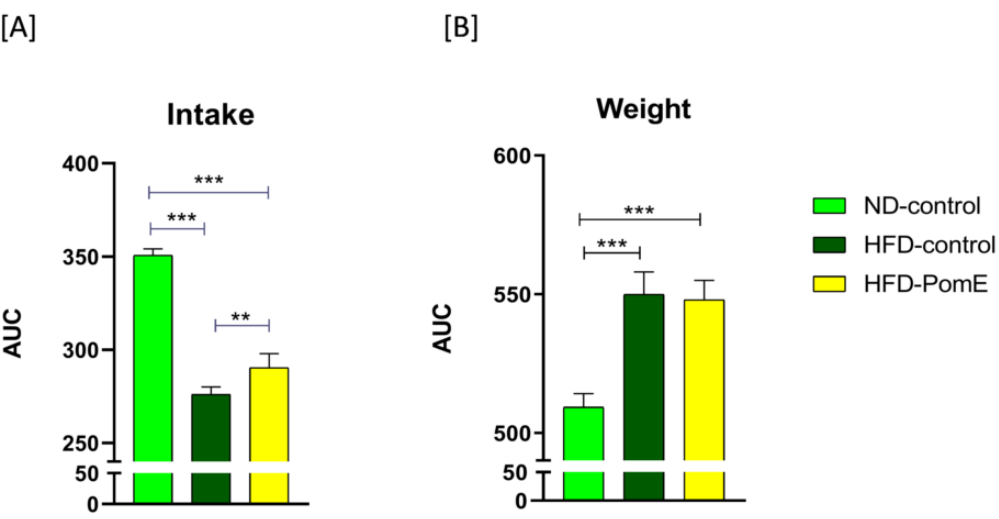
Figure 2. Comparison of food intake ( A ) and weight ( B ) of the animals of ND-control group with that of HFD-control and HFD-PomE groups. Statistically significant values are indicated with asterisks based on their p -value, ** p < 0.01, *** p < 0.001.